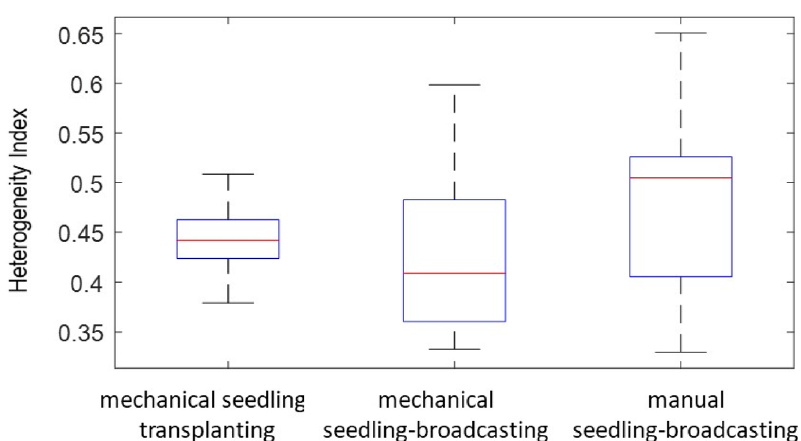
Figure 10. Comparison of the distribution quality of rice clusters under three transplanting